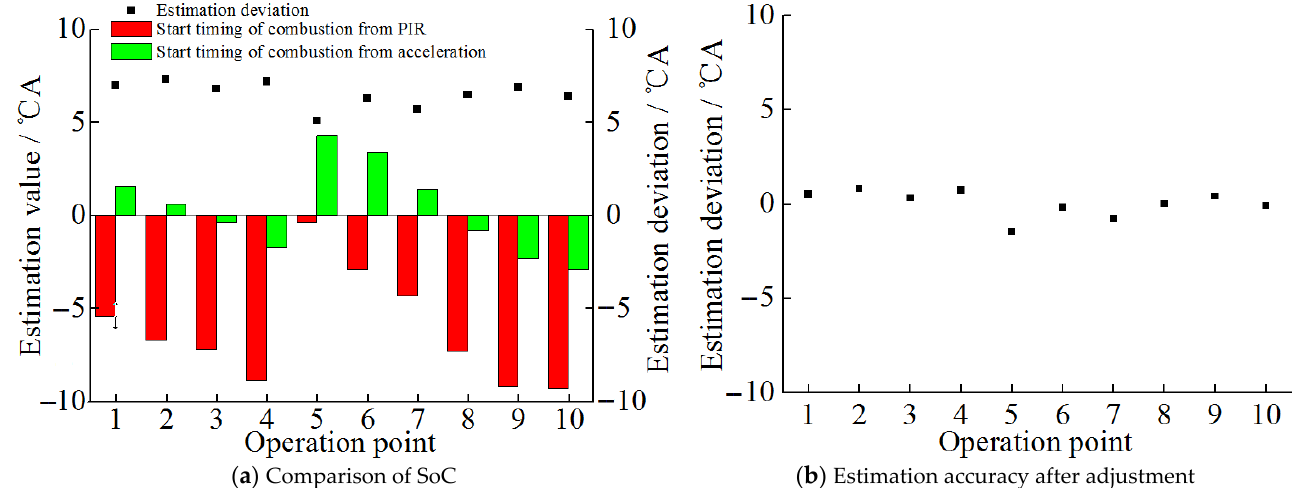
Figure 14. Accuracy comparison of SoC from PIR and acceleration. The operation points named 1 to 10 correspond to the engine operating condition showed in Table 3.